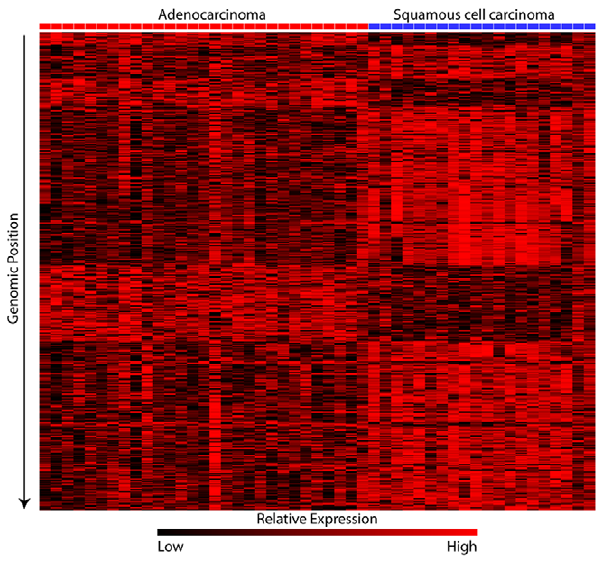
Figure 2. Differential expression as a result of subtype specific copy number alterations. Transformed absolute expression data for the 492 unique genes exhibiting disruption in expression levels as a result of copy number differences are displayed. In addition, these genes are up or down-regulated in the subtype which they are disrupted compared to normal lung tissue (see results). High-level expression is indicated by red while black indicates progressively lower levels of expression. The AC samples are indicated by red highlighting on the top of each column, while SqCC samples are indicated by blue highlighting. Each gene is sorted according to its chromosomal position. There is a clear distinction in the expression of these genes indicating their specific involvement in the